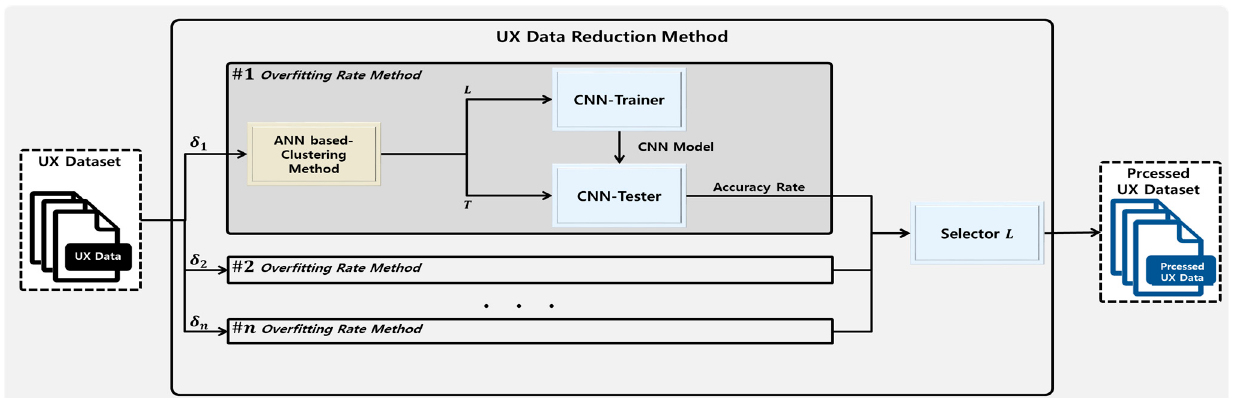
Figure 2. Proposed UX framework including UX data reduction method for game agent AI system.